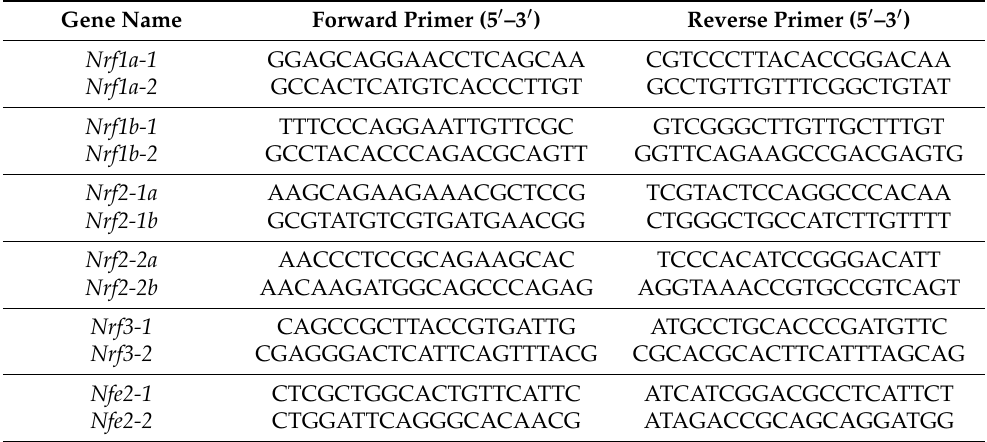
Table 1. Primers used for the